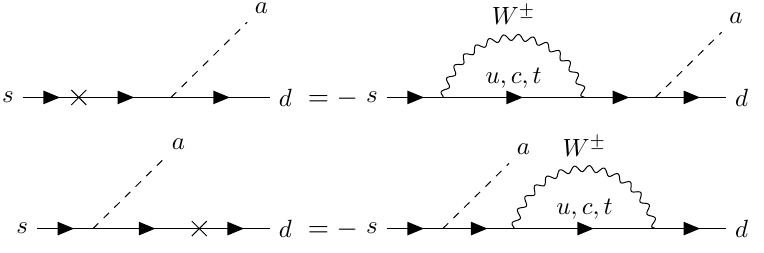
Figure 8 . Relation between counterterm insertions and W ± loops for s → d + a .